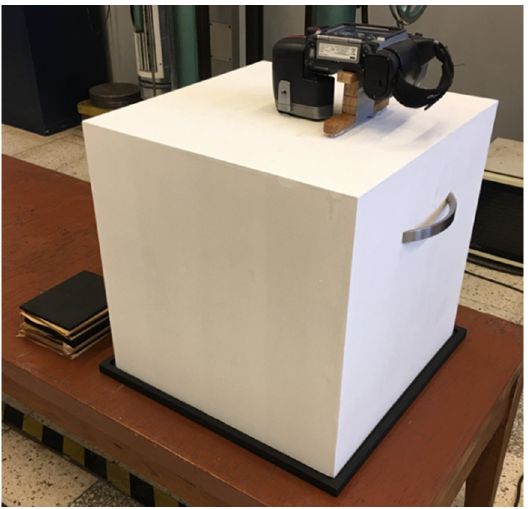
Figure 6. The view of the light-tight imaging station for taking photos during measurements, eliminating the effects of external radiation.